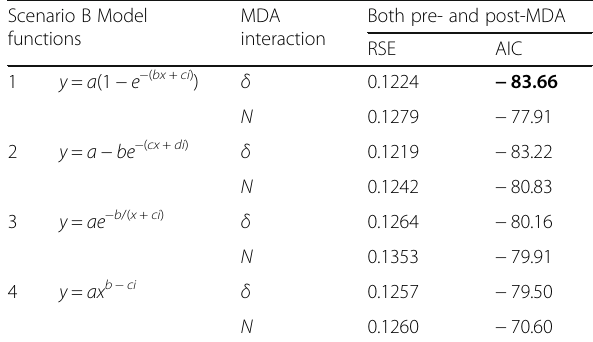
Table 2 Comparison of the Combined Scenario B